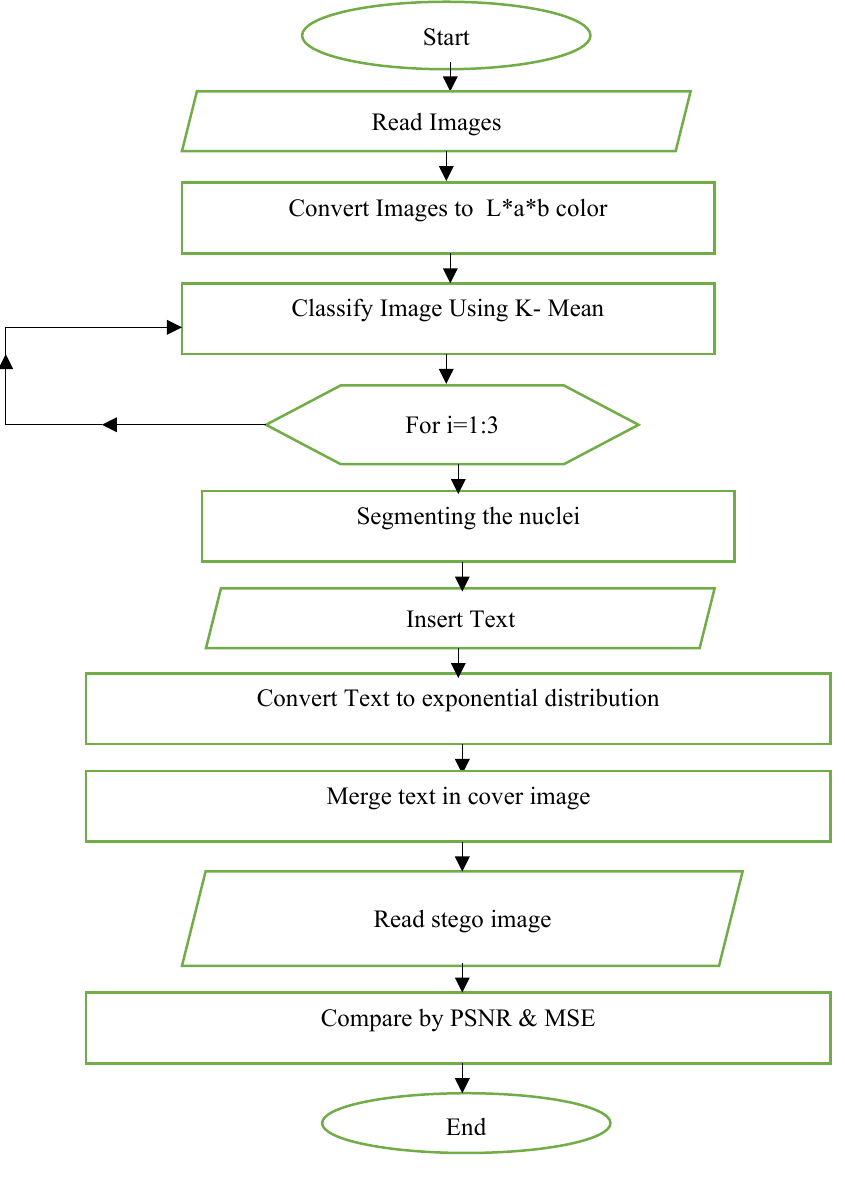
Figure 2. Proposed system